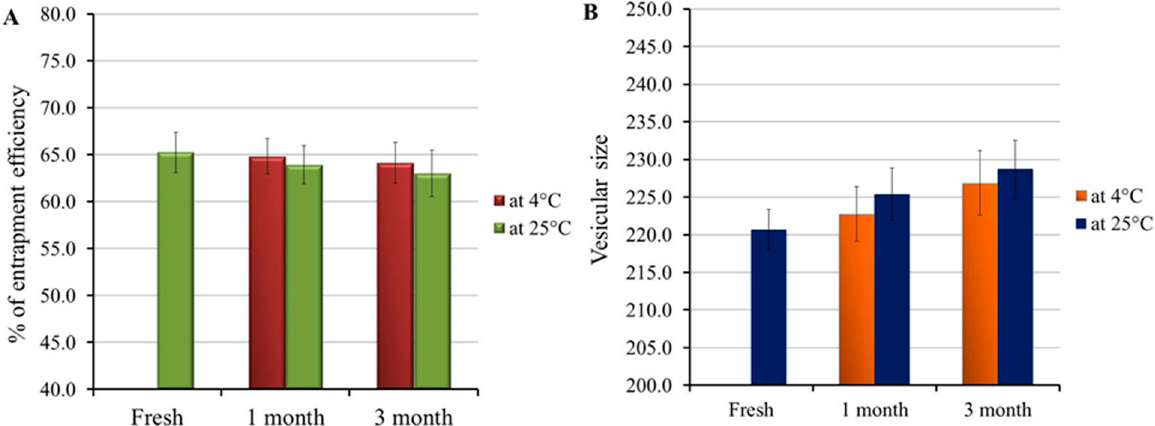
Figure 2. Stability study outline for colchicine loaded niosome formulation investigated at 4 °C and 25 °C for 1 and 3 months in terms of ( A ) vesicular size and ( B ) entrapment efficiency, compared to freshly prepared formulation.